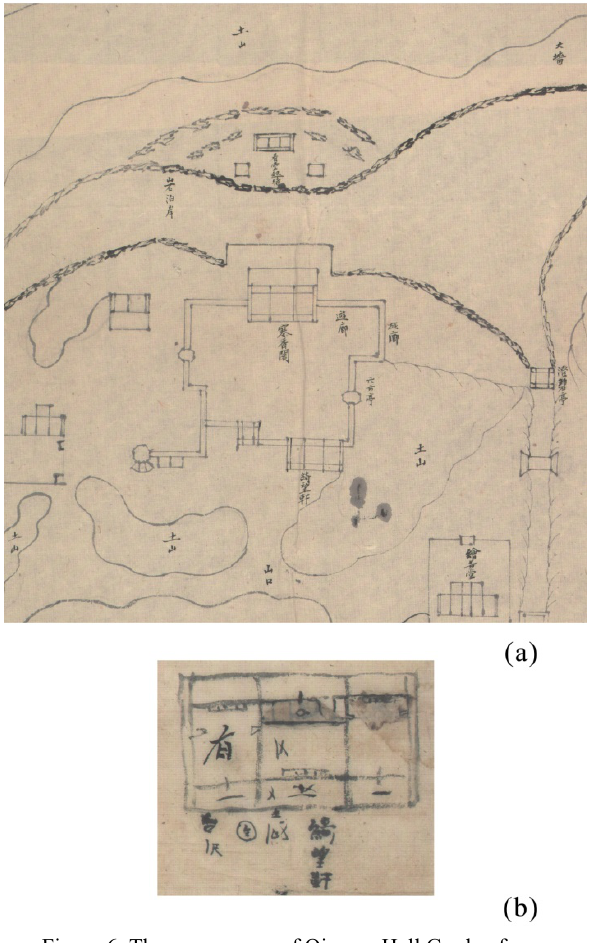
Figure 6. The survey map of Qiwang Hall Garden from theYangshi Lei Chart (National Library of China,